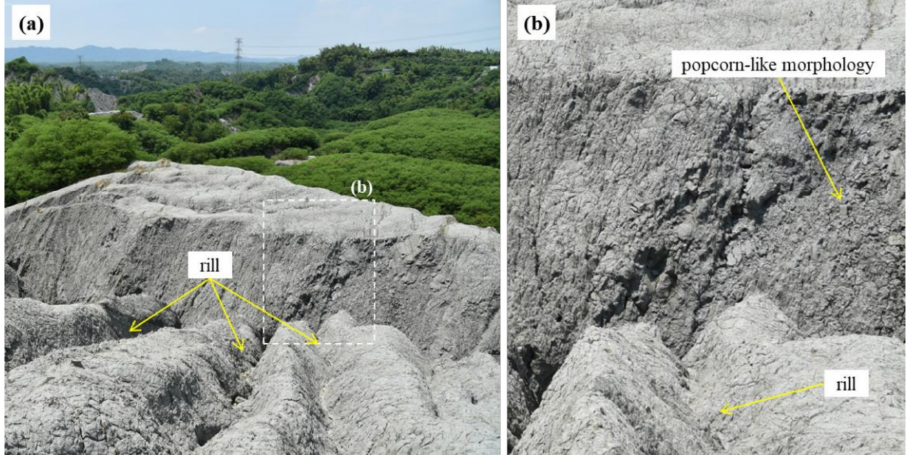
Figure 9. Popcorn-like morphology ( a ) and rill on steep hillslopes ( b ).